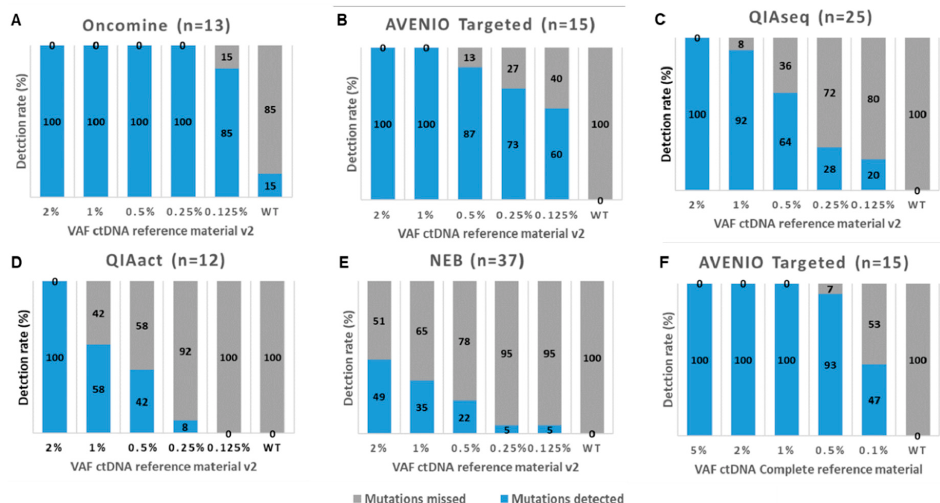
Figure 3. Detection rates of five commercially available mutation analysis kits. Shown are the detection rates of mutations (SNVs and indels) in the Seraseq ctDNA Reference Material v2 at various variant allele frequencies (VAF) for ( A ) the Oncomine Lung cfDNA Assay (Oncomine), ( B ) the AVENIO Targeted Kit (AVENIO Targeted), ( C ) the QIAseq Human Actionable Solid Tumor Panel (QIAseq), ( D ) the GeneRead QIAact Lung UMI Panel (QIAact), and ( E ) the NebNext Direct Cancer Hotspot Panel (NEB). ( F ) Shown are the detection rates of mutations in the Seraseq ctDNA Complete reference Material for the AVENIO Targeted kit. The numbers in brackets reflect the number of mutations covered by the panel.